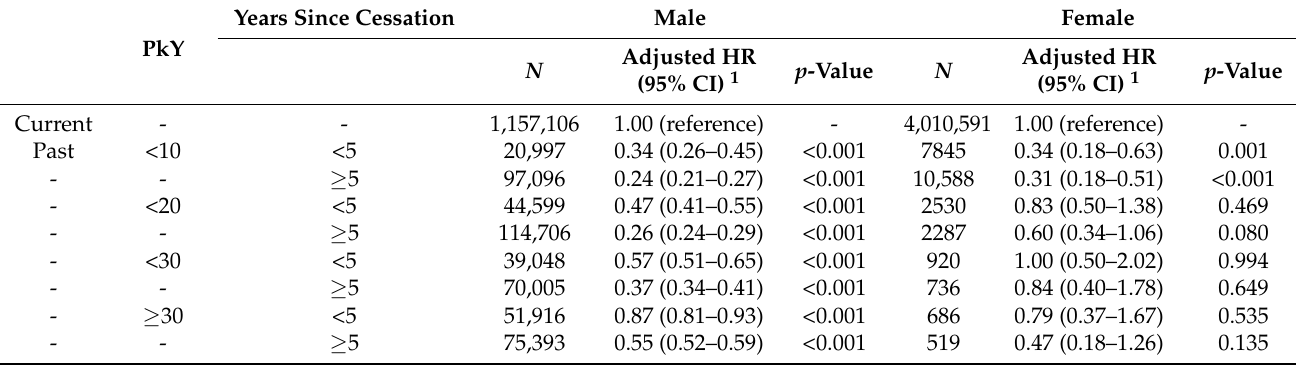
Table 4. Adjusted risk of lung cancer according to combination of smoking quantity and duration of smoking abstinence.